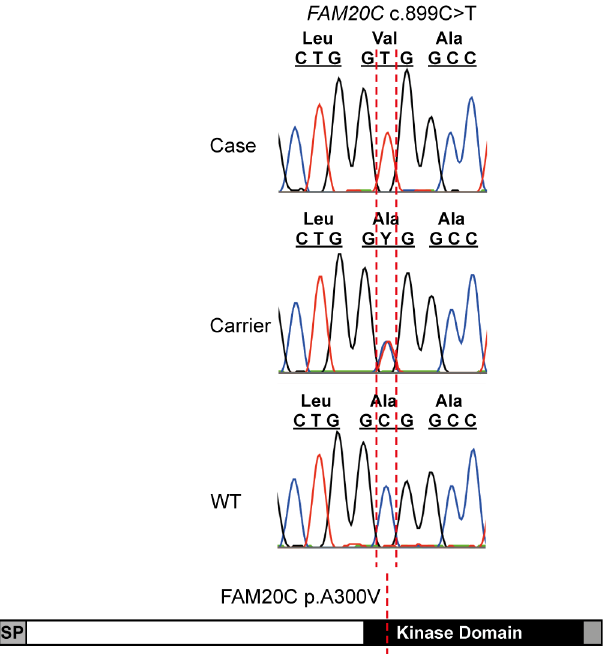
Fig 5. Whole genome sequencing of three Border Collies affected with tooth attrition reveals a missense variant, FAM20C c.899C > T, in the conserved kinase domain of the protein (p.A300V).